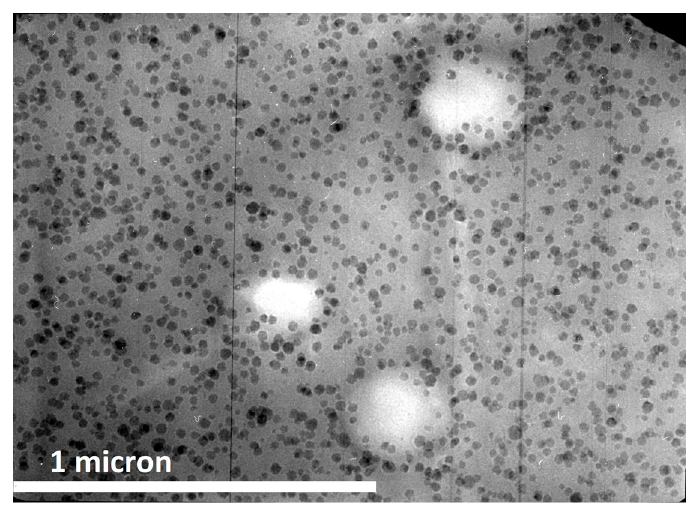
Figure 9. TEM picture of DGEBA modified with reactive liquid rubber (CTBN) and nanosilica [24].